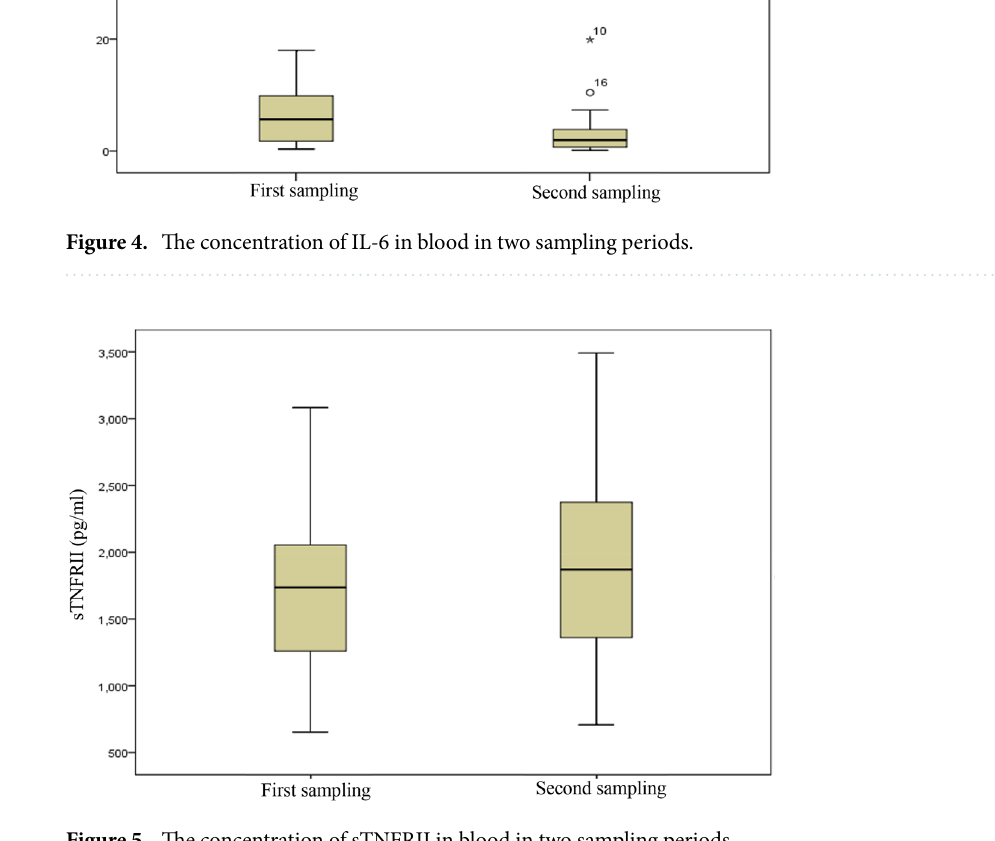
Figure 5. The concentration of sTNFRII in blood in two sampling